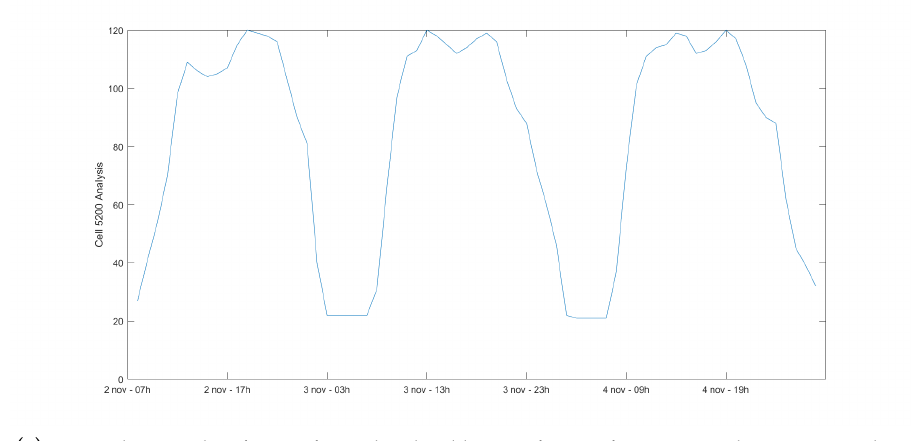
Figure 4. ( a ) Graphical representation of the network usage by hour in the Trento province data set for complete two months (November to December of 2013). ( b , c ) Detailed classification of the city of Trento and its old town during a particular period from 2 November to 4